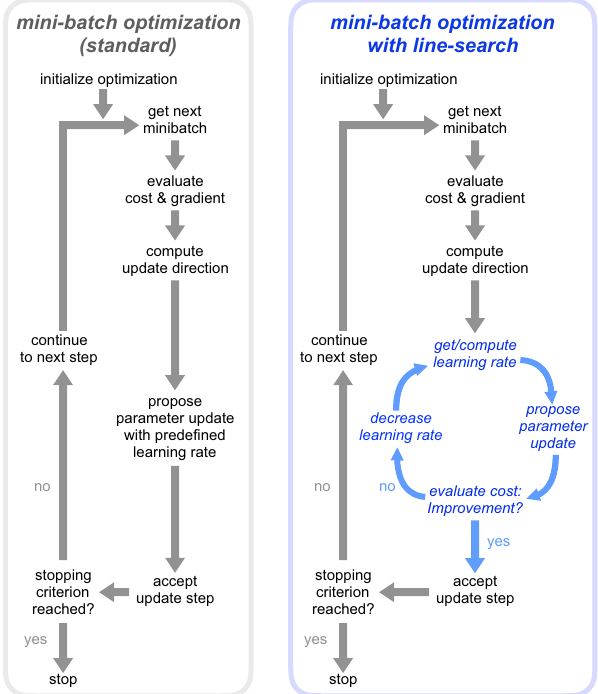
Fig. 8 Comparison of standard mini-batch optimization and mini-batch optimization with line-search. Left panel: Standard mini-batch optimization uses a prescheduled learning rate, which determines the step size during optimization regardless of whether an optimization step leads to an improvement or not. Right panel: If line-search is enabled, the objective function is reevaluated on the same mini-batch and checked for improvement. If no improvement is achieved, the learning rate is reduced until either improvement is achieved or until the maximum number of line- search steps is